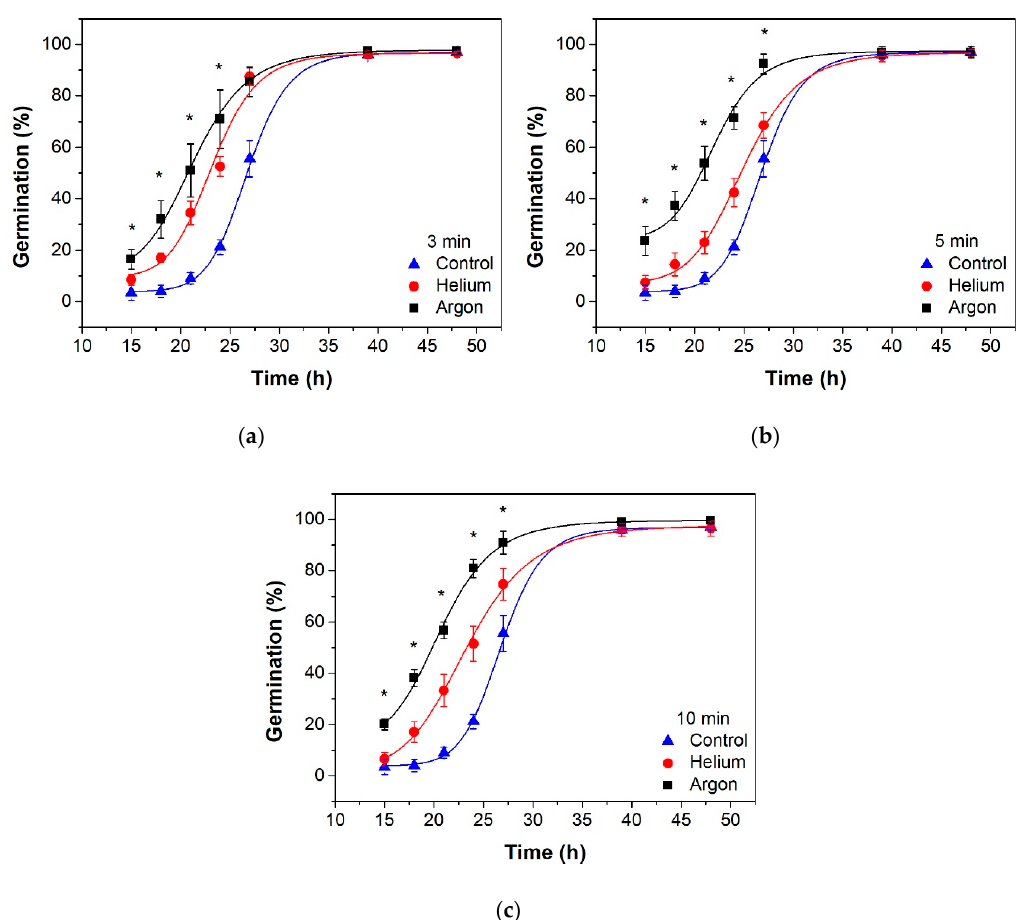
Figure 8. Comparison of germination acceleration of wheat seeds treated with both discharges (argon in black and helium in red) for ( a ) 3 min, ( b ) 5 min, and ( c ) 10 min. Germination curves were fitted with the Hill function. * represents a statistically significant difference ( p ≤ 0.001–0.02).